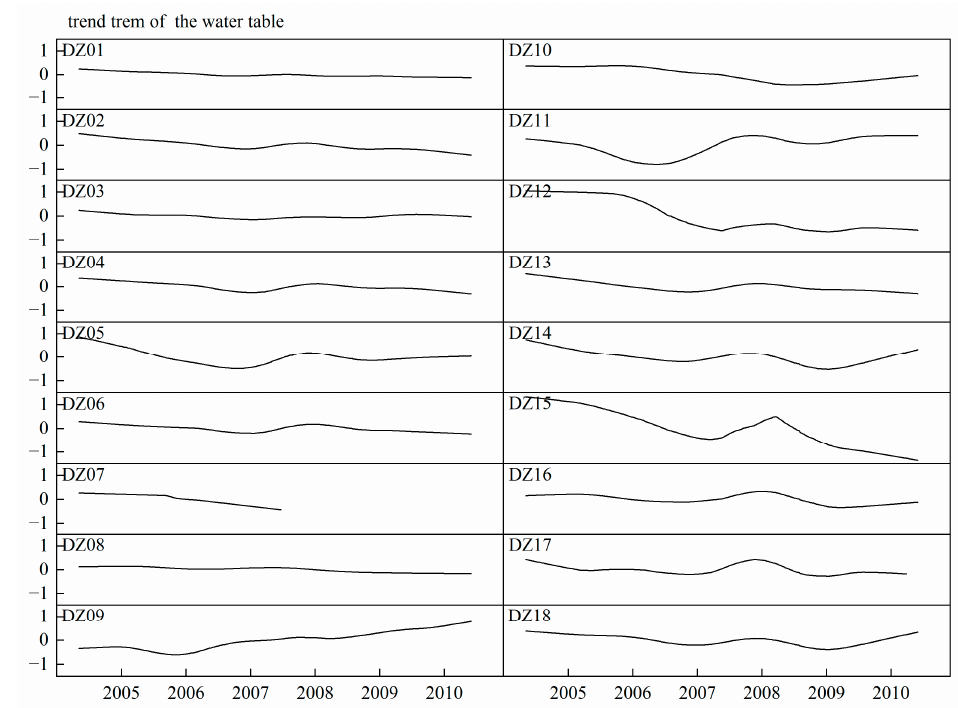
Figure A1. The trend term of GWL of each observational well varies with time.